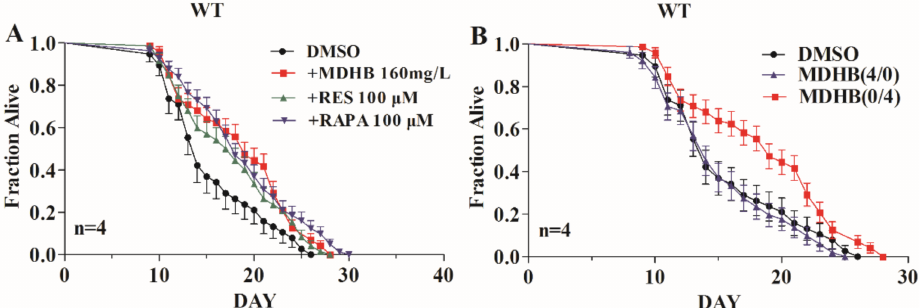
Figure 1. Methyl 3,4-dihydroxybenzoate (MDHB) extends adult life span of wild-type